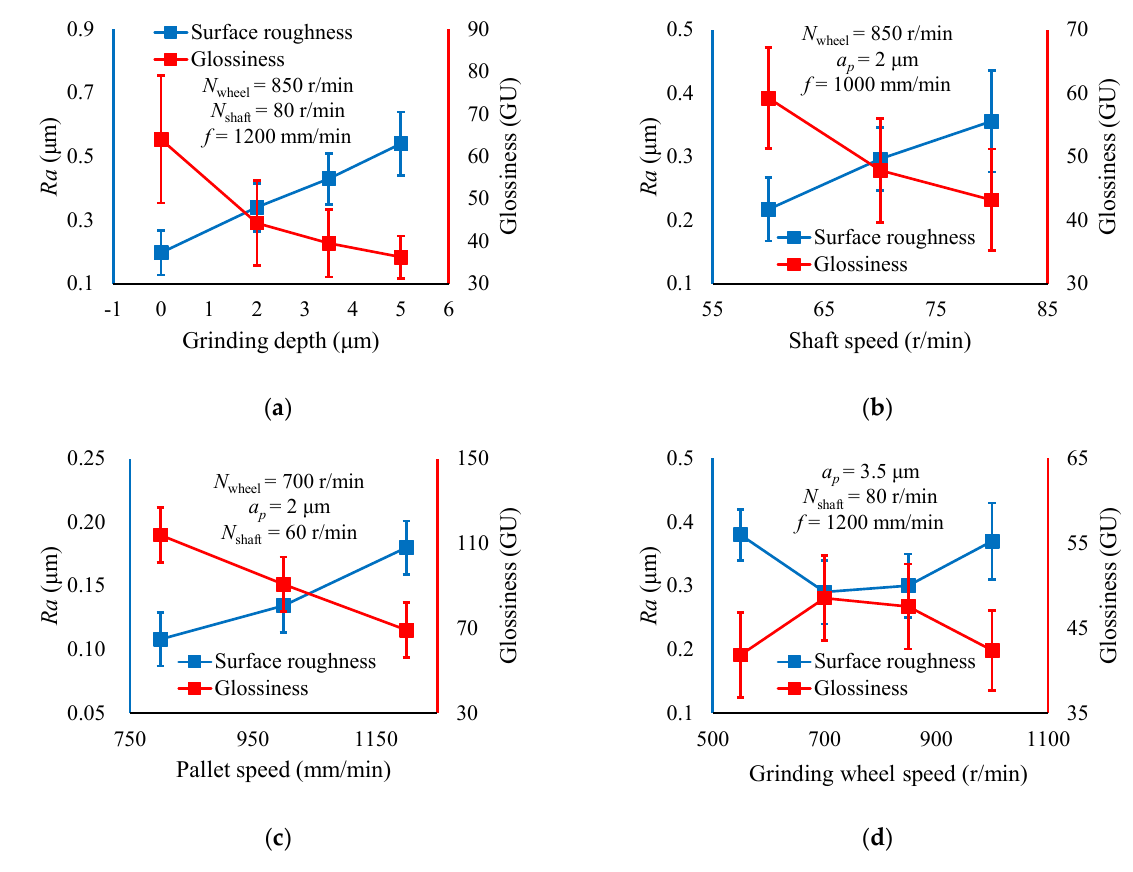
Figure 4. The influence of three grinding parameters on surface roughness and glossiness: ( a ) grinding depth, ( b ) shaft speed, ( c ) pallet speed, ( d ) grinding wheel speed. For grinding wheel speed, lower surface roughness values and higher glossiness val ‐ ues are obtained in the range from 700 to 850 r/min. The spindle current standard devia ‐